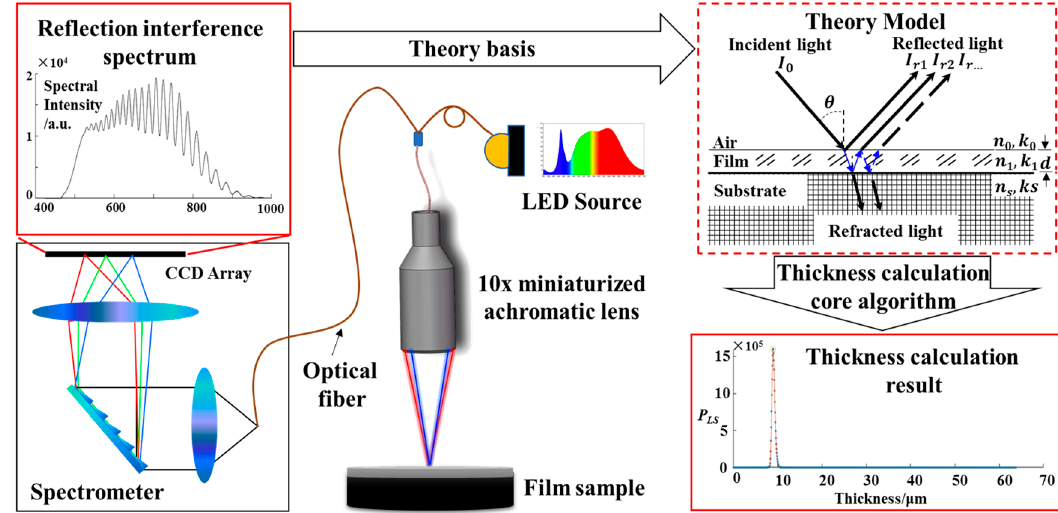
Figure 1. Schematic diagram of the thin-film thickness measurement principle.